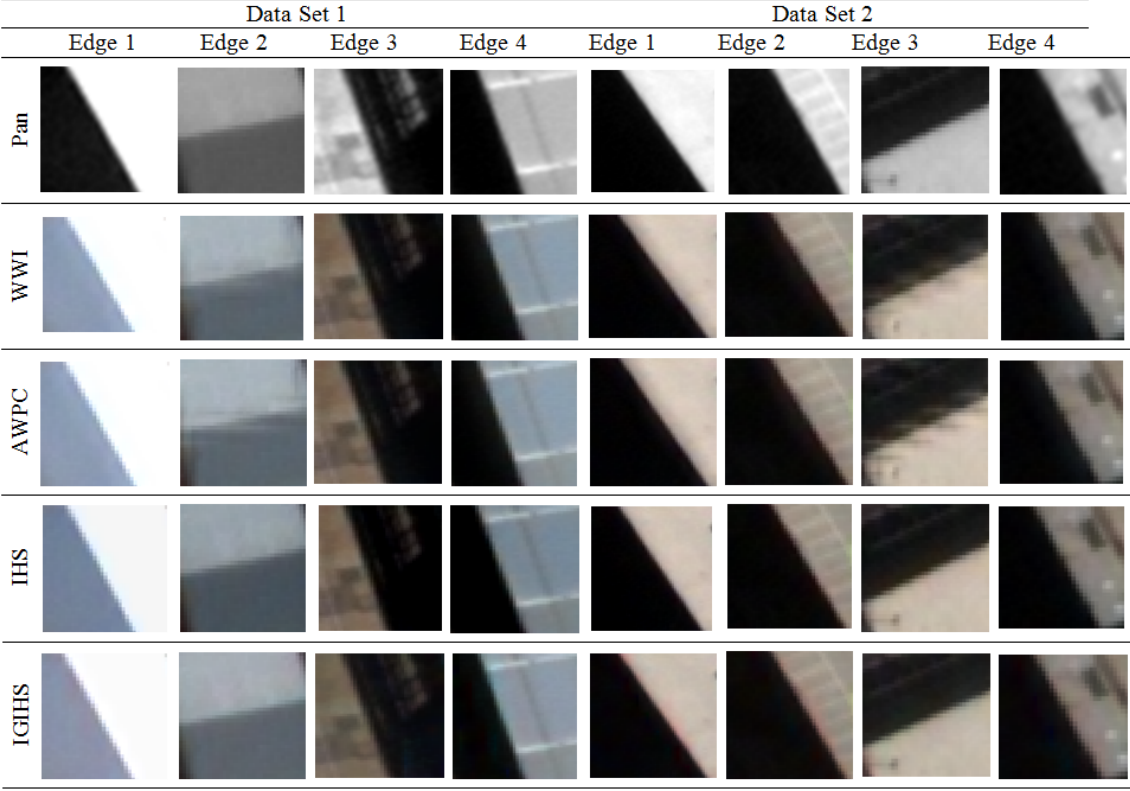
Figure 8. Samples of selected edges in both data sets and for all pan-sharpening